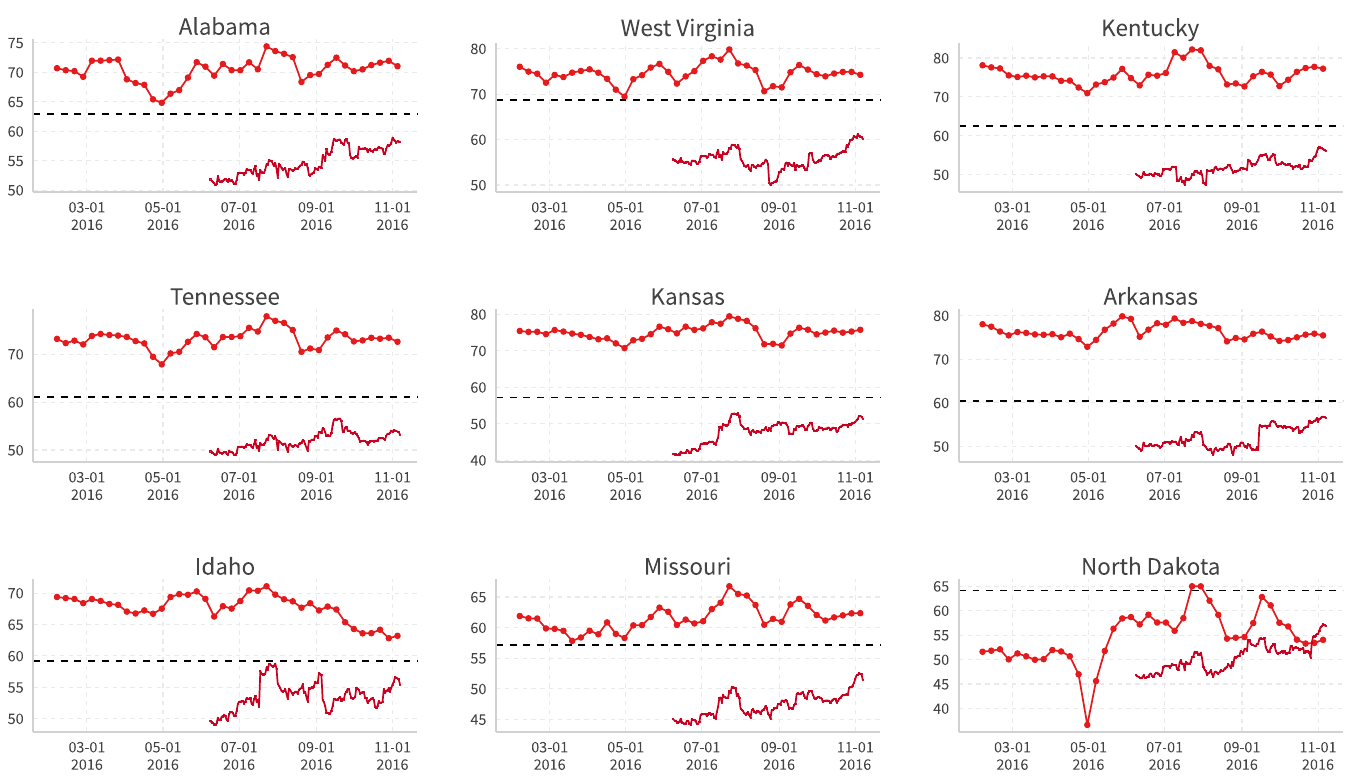
Fig 18. Trump’s Facebook support rate (dotted line), 538 polling average (undotted line), and 2016 actual vote share (dashed line) in selected red states. Facebook support rate: Share of user’s ideology closer to Trump. 538 Polling Average: “Nowcast” from [27]. Dickey-Fuller and Phillips-Perron cointegration tests after controlling for candidate-state fixed effects are implemented, where the null hypothesis of no cointegration between these two series is rejected.